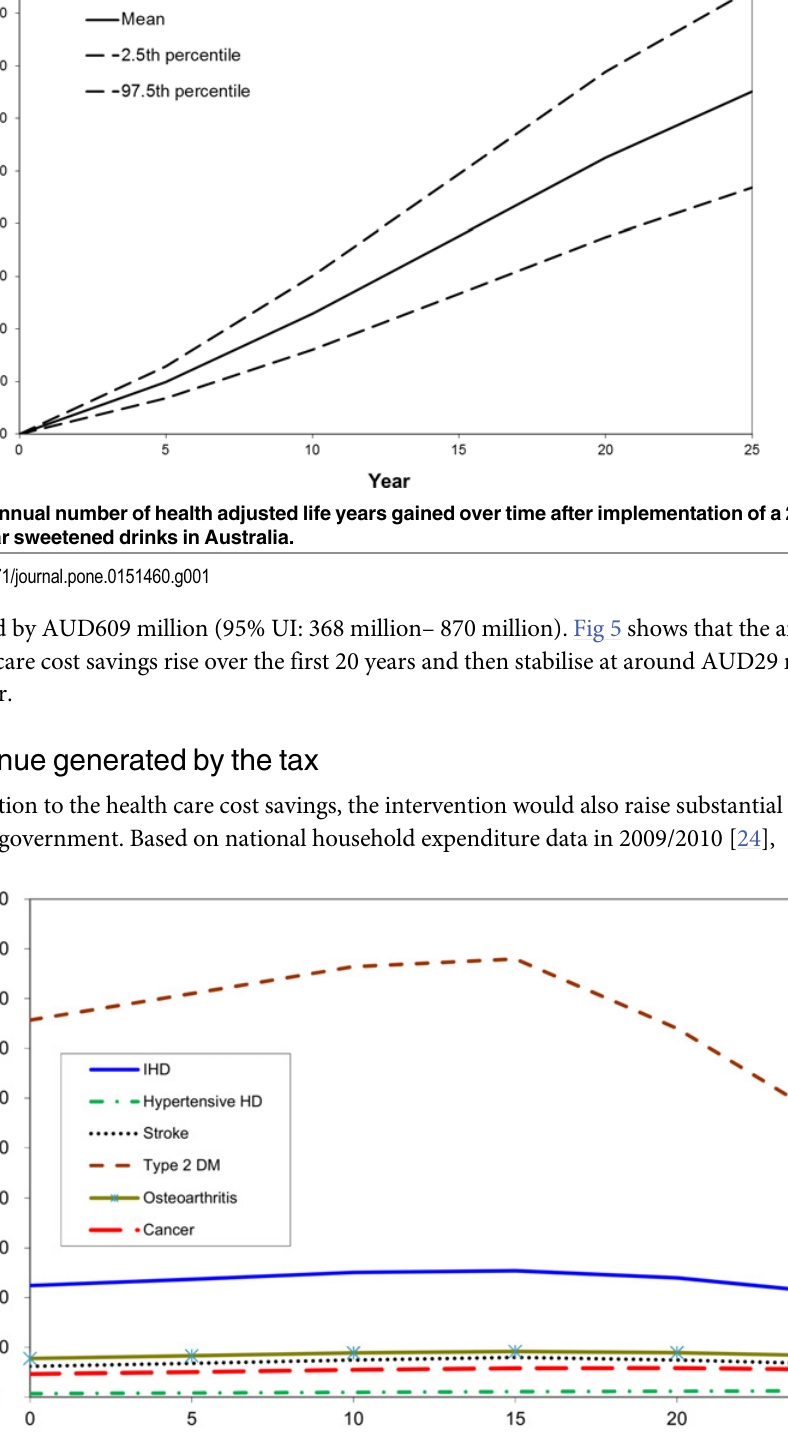
PLOS ONE | DOI:10.1371/journal.pone.0151460 April 13,